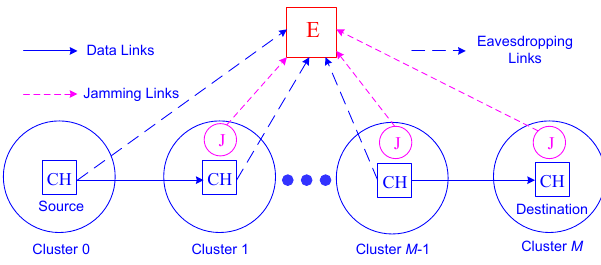
Figure 1 . System model of the proposed